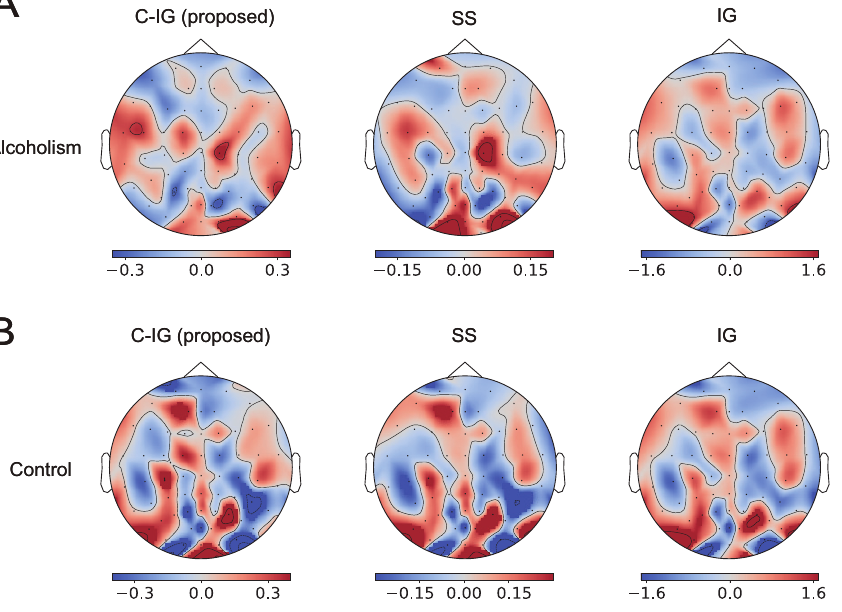
Figure 4. Contributions of EEG electrodes over the scalp to classify alcoholism ( A ) and control ( B ) using the spatiotemporal CNNs. The average contributions of the methods applied to 100 data examples from the UCI EEG dataset are shown. The red and blue areas represent positive and negative contributions to the classifications, respectively. The proposed compensated integrated gradients method is shown (left panels), while the Shapley sampling shows the desired contributions as a reference (middle panels), and integrated gradients show the contributions obtained using the original integrated gradients method with the zero-input baseline (right